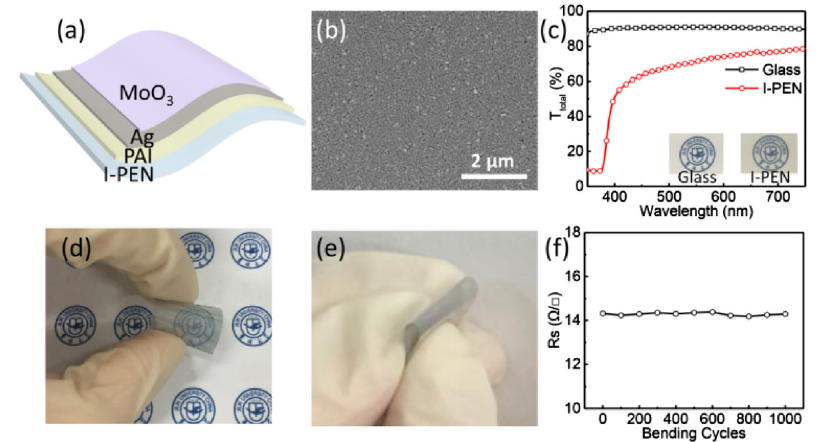
Figure 3: (a) Schematic illustration of the metal oxide/ultrathin Ag/polymer (MAP) electrode fabricated on flexible industrial- grade polyethylene naphthalate (I-PEN). (b) Surface morphology image of the MAP/ I-PENelectrodeswith9nmAg.(c)Measured total transmittance spectra and photo- graphs of the I-PEN substrates compared with glass substrates. (d) – (e) Optical im- ages of the MAP/I-PEN electrode. The bendingradiusin(e)is1mm.(f)Mechanical robustness measurement of the flexible MAP/I-PEN electrode with 1000 times bending